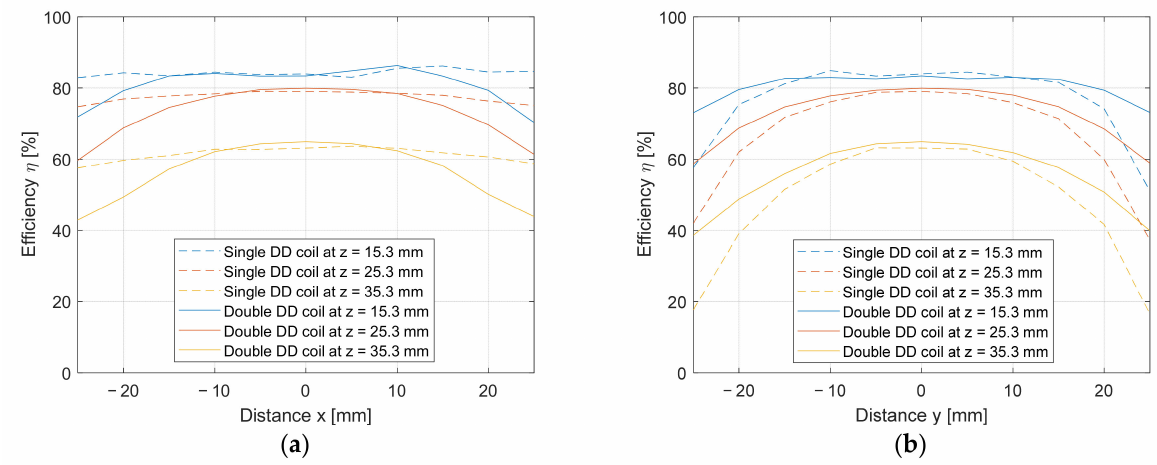
Figure 25. Impact of horizontal misalignment on IPT system efficiency: ( a ) misalignment in the direction of the x -axis; ( b ) misalignment in the direction of the y